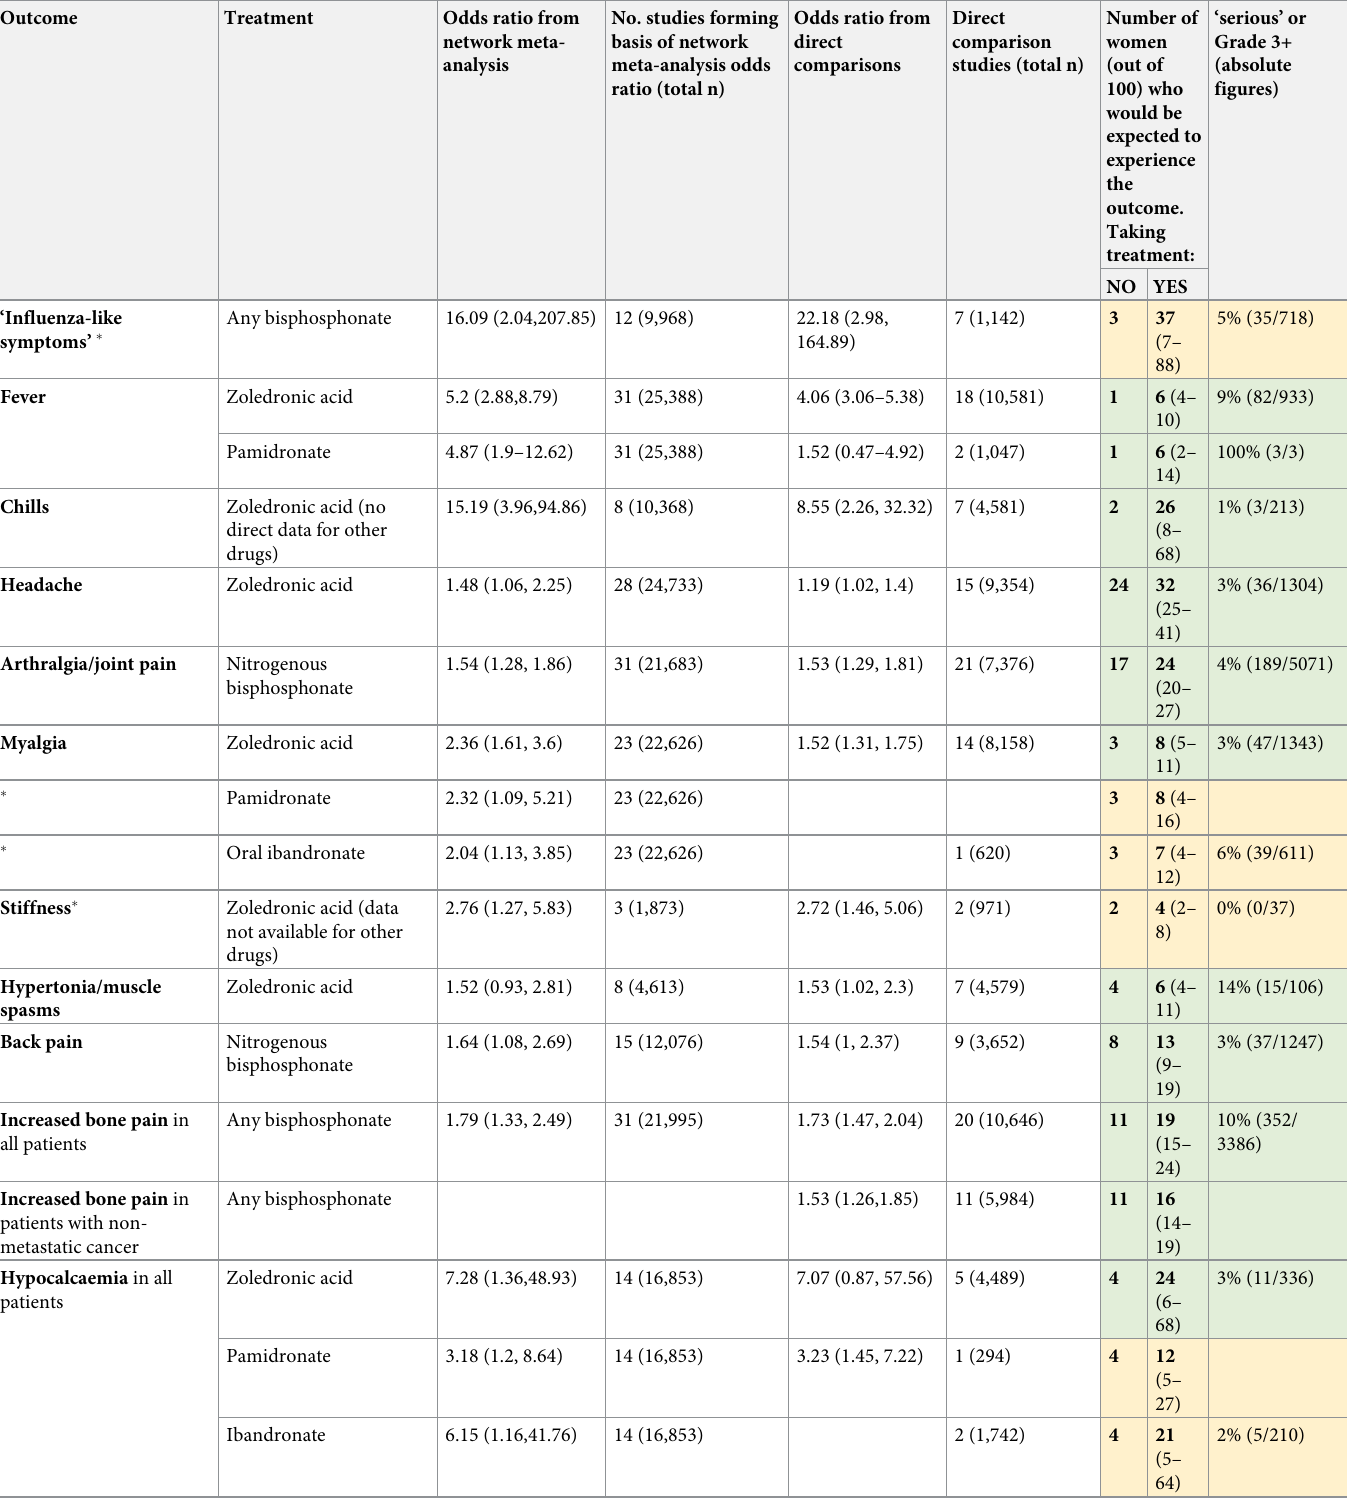
Table 1. Adverse effects of bisphosphonate drugs in women with breast